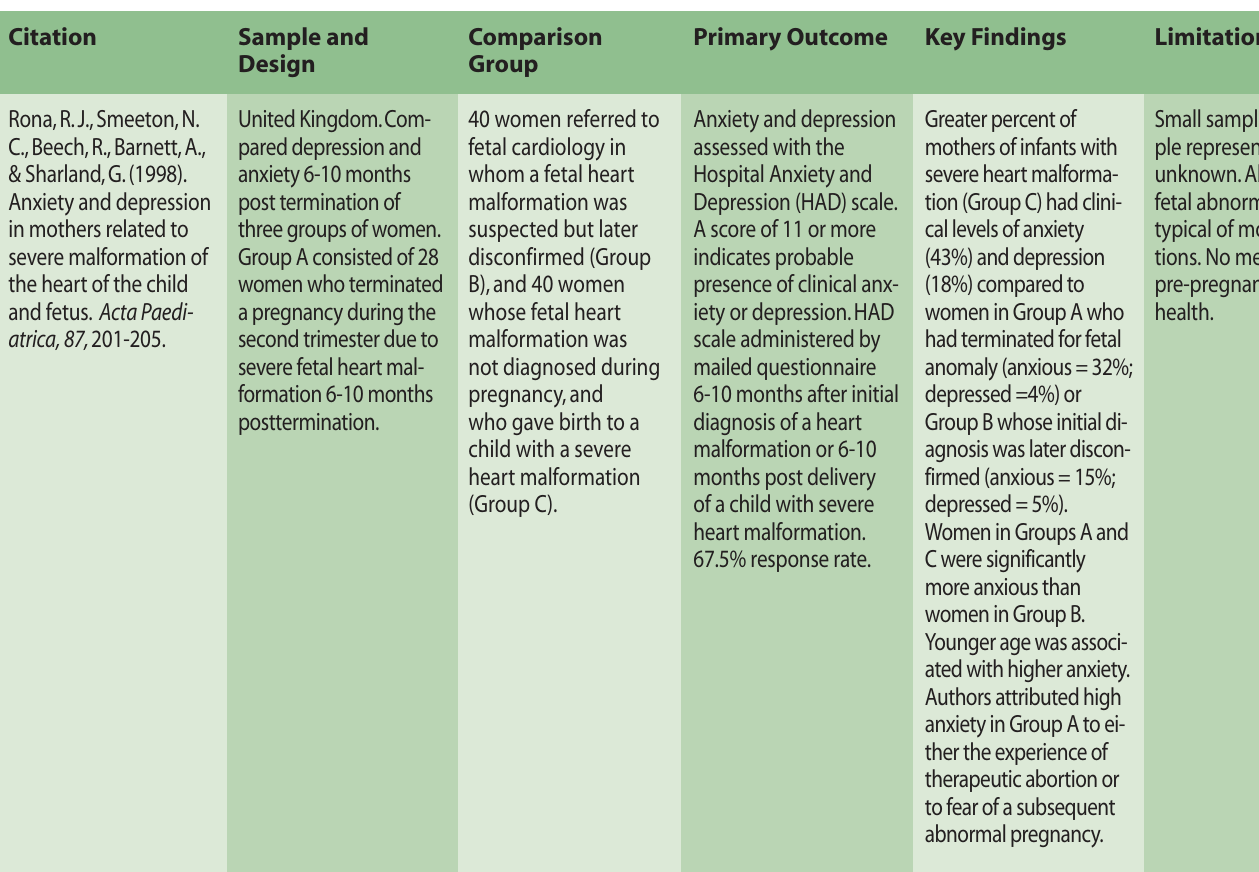
Table 4: Abortion for Reasons of Fetal Anomaly (continued)